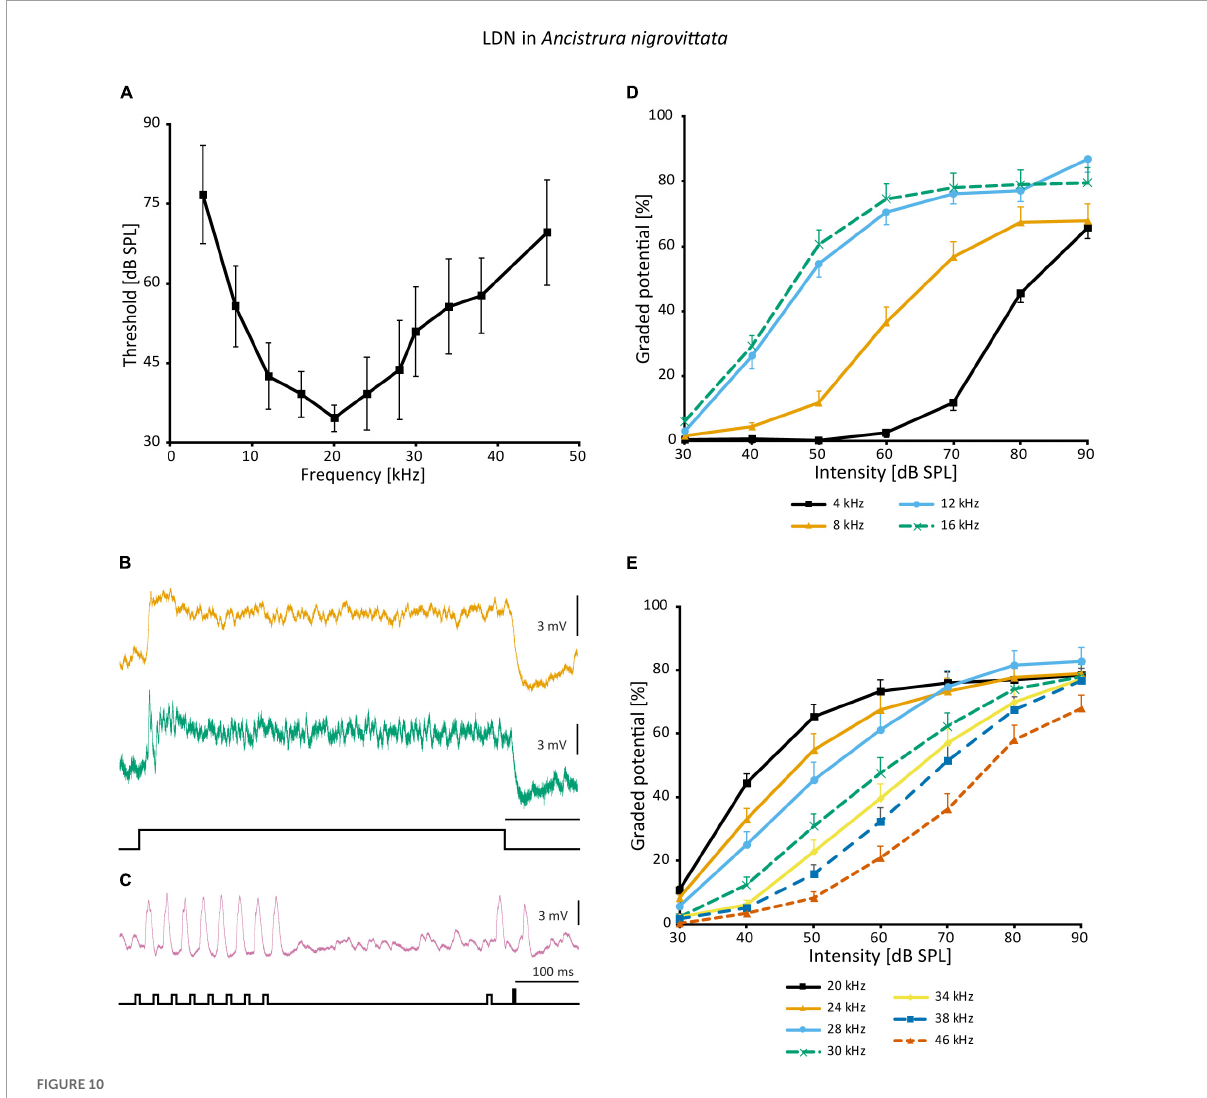
FIGURE10 Auditory responses of LDN in A. nigrovittata . (A) Frequency tuning (mean ± SD) of LDN from 9 to 10 females and 7 to 8 males. (B) Response patterns of two LDN in a female (upper) and a male (lower) to a 500 ms white noise stimulus of 70 dB SPL. (C) Response of an LDN in a female to an artificial duet between a male and a female at 60 dB SPL. (D,E) Intensity response curves for the indicated frequencies with 50 ms stimuli (mean ± SEM; 10 females and 8 males, except for 8 kHz (9f, 7 m) and 38 kHz (10 f, 7 m). Response curves up to 16 kHz (D) have a steeper rise and a narrower dynamic range than those in the ultrasound (E)